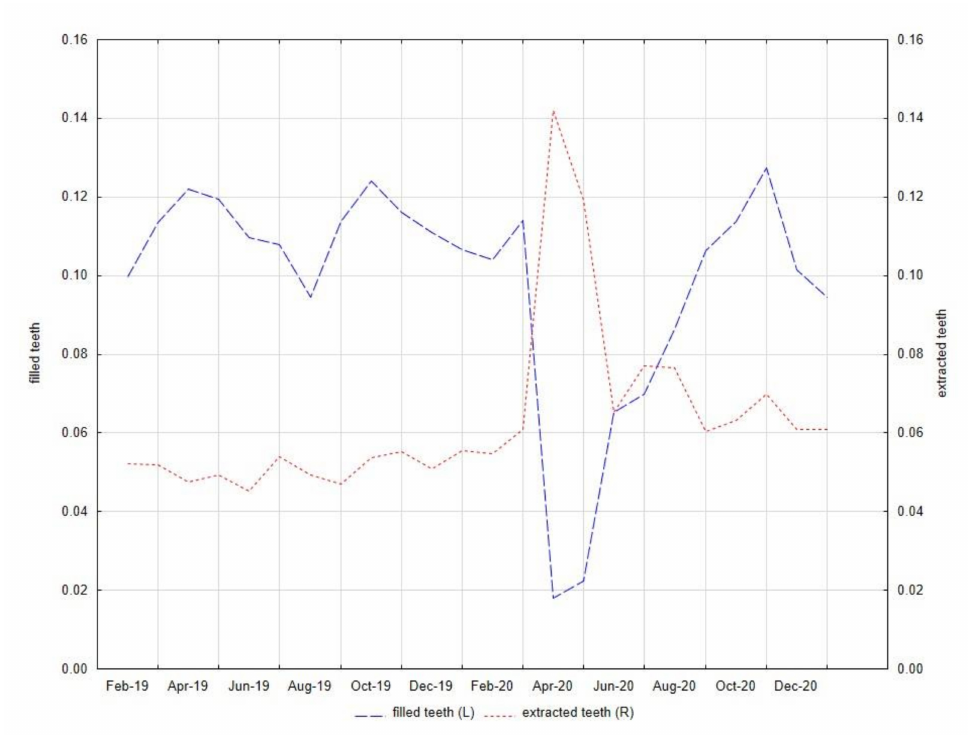
Figure 6. The standardized numbers of filled teeth and extracted teeth in the University Center of Dentistry and Specialized Medicine (Poznan, Poland) from 1 February 2019 to 31 January